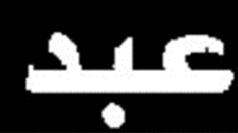
Figure 9. Cropped first word.